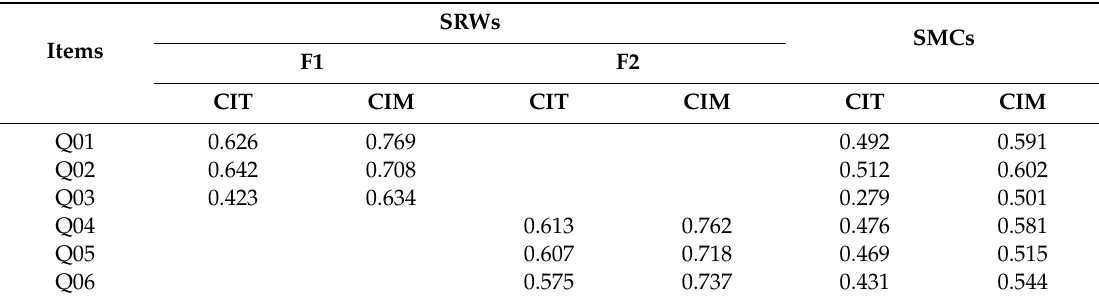
Table 17. Standardized regression weights (SRWs) and squared multiple correlations (SMCs) of the factors related to the work design (F1) and work development (F2).